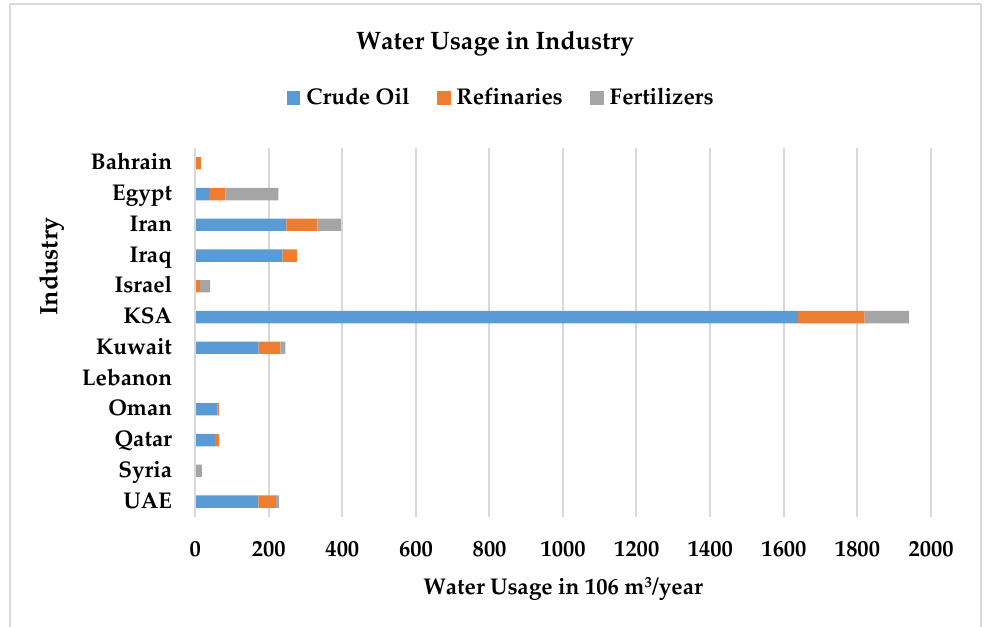
Figure 4. Industrial water consumption in the Middle East in 2011. The data are acquired from Sakhel et al. [57].